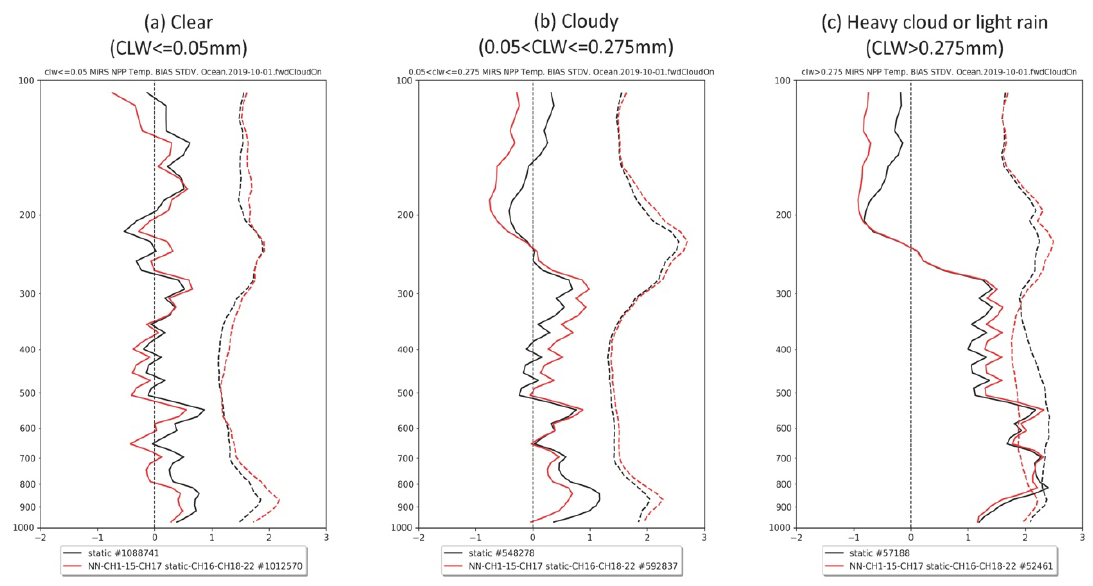
Figure 5. MiRS temperature profiles (K) validated with ECMWF analyses for SNPP/ATMS over ocean for ( a ) clear, ( b ) cloudy, and ( c ) heavy cloud or light rain conditions on 1 October 2019. The black lines are for MiRS using the static bias correction method, and red for the NN bias correction method. Solid lines are for bias, and dashed lines for standard deviation.